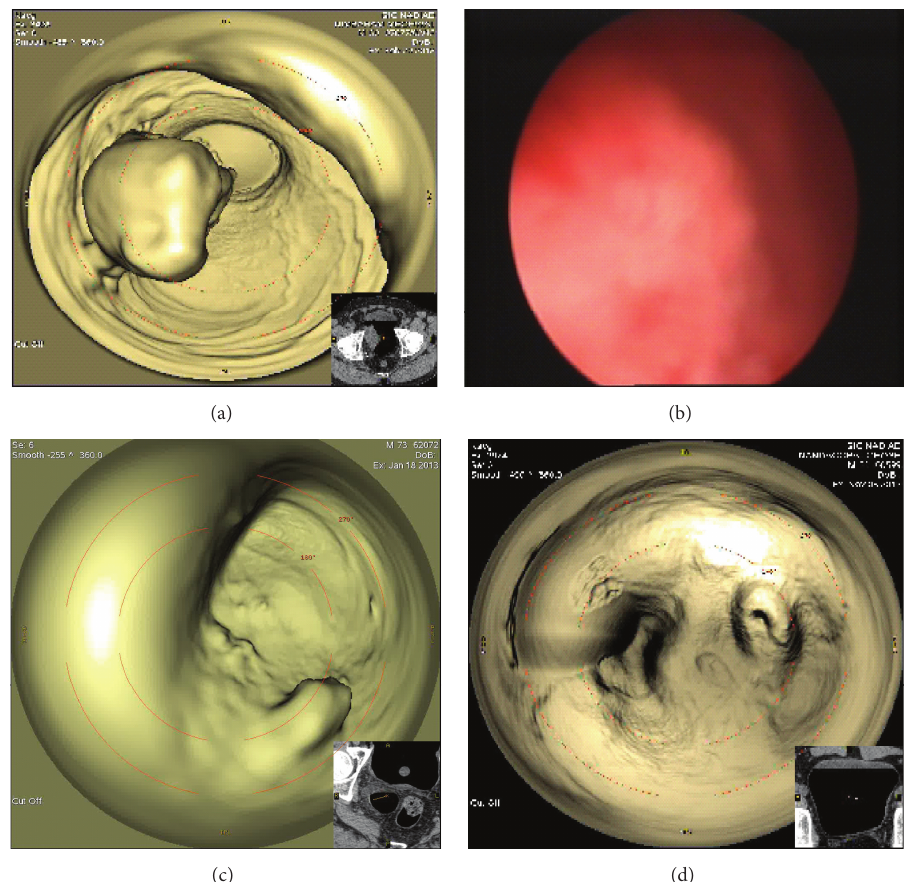
Figure 1: (a-b)Large right lateral wall growth in a patient presenting with gross painless hematuria on CTVCand CPE,respectively. (c) CTVC image of inside the bladder diverticulum showing papillary lesions. (d) Follow-up case of TCC bladder with normal findings on CTVC.